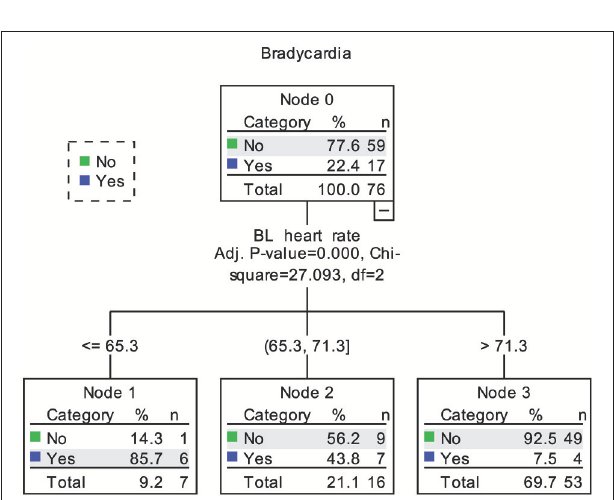
FIGURE 4 | Decision tree of predictors for bradycardia caused by fingolimod. BL, baseline. In node 1, 2 patients already had bradycardia before fingolimod intake were not